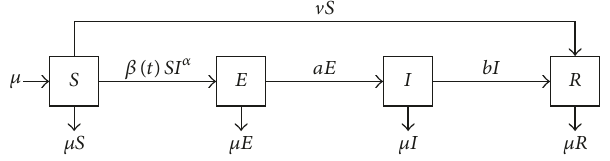
Figure 2: Flowchart of the continuous-time deterministic chick- enpox model. Boxes represent compartments, horizontal arrows representtransitionsbetweencompartments,anddownwardarrows represent people leaving the system.